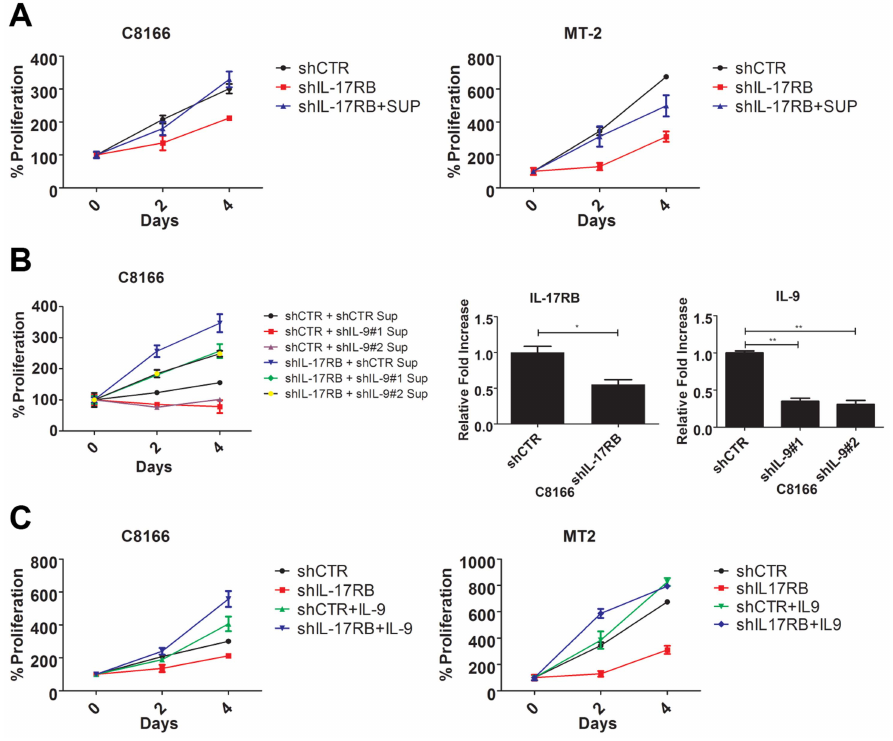
Figure 6. IL-9 is a key target gene downstream of IL-17RB that regulates the proliferation of HTLV-1 transformed cells. ( A ) Proliferation/viability assay of C8166 and MT-2 cells transduced with lentiviruses expressing control or IL-17RB shRNA using CellTiter-Glo. Cells knocked down for IL-17RB were grown in conditioned media (SUP) from the corresponding cell lines. ( B ) Proliferation/viability assay of C8166 cells transduced with lentiviruses expressing control or IL-17RB shRNA. Cells with suppressed IL-17RB expression were grown in conditioned media (Sup) from C8166 expressing control (CTR) or the indicated IL-9 shRNAs (top panel). qRT-PCR of IL-17RB and IL-9 mRNAs in C8166 cells transduced with lentiviruses expressing IL-17RB or IL-9 shRNAs (bottom panel). ( C ) Proliferation/viability assay of C8166 and MT-2 cells transduced with lentiviruses expressing control or IL-17RB shRNA, in the presence or absence of recombinant IL-9 (20 ng/ml) for the indicated times.